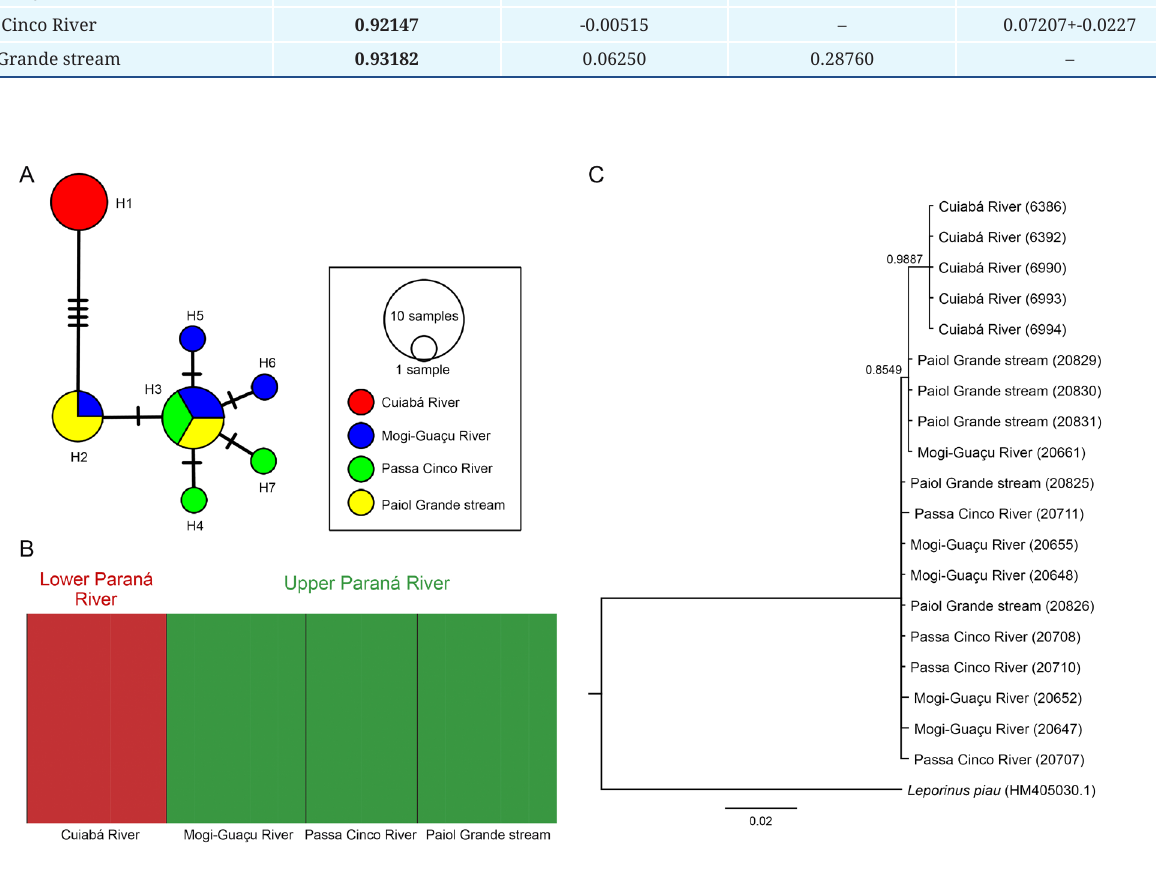
FIGURE 4 | Molecular data of Parodon nasus from La Plata basin. A. Haplotype network showing the relationship among the sequences. B. Structural population inference by BAPs (K = 2) for the four populations showing the division between Upper and Lower Paraná River systems; C. Bayesian inference tree showing the phylogenetic relationship of the sequences (numbers on the branches correspond to posterior probability; numbers in parentheses correspond to specimen voucher